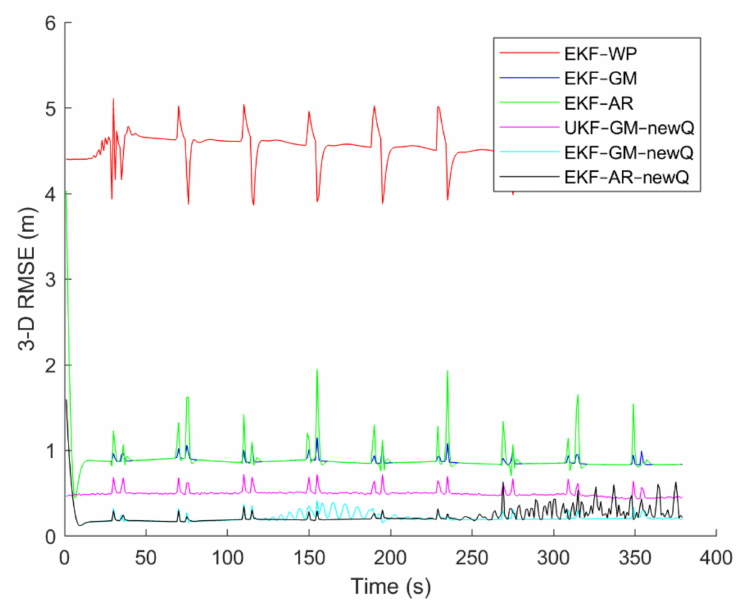
Figure 20. The positioning error of different methods in the fifth scenario.